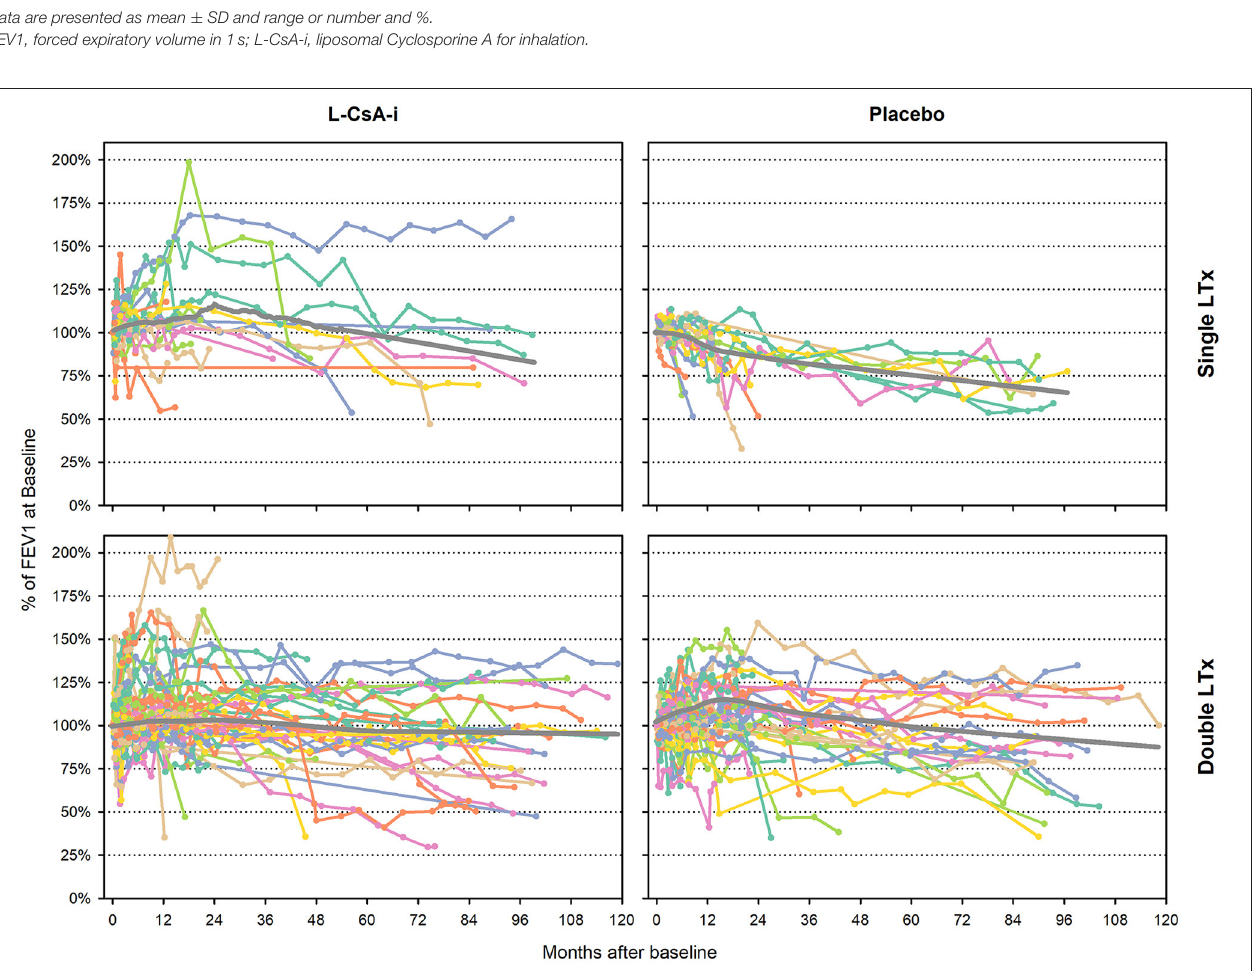
contrasts), COPD and CF decreased the risk while ILD and other underlying diagnoses increased the risk. No significant interaction between underlying diagnosis and type of transplantation was